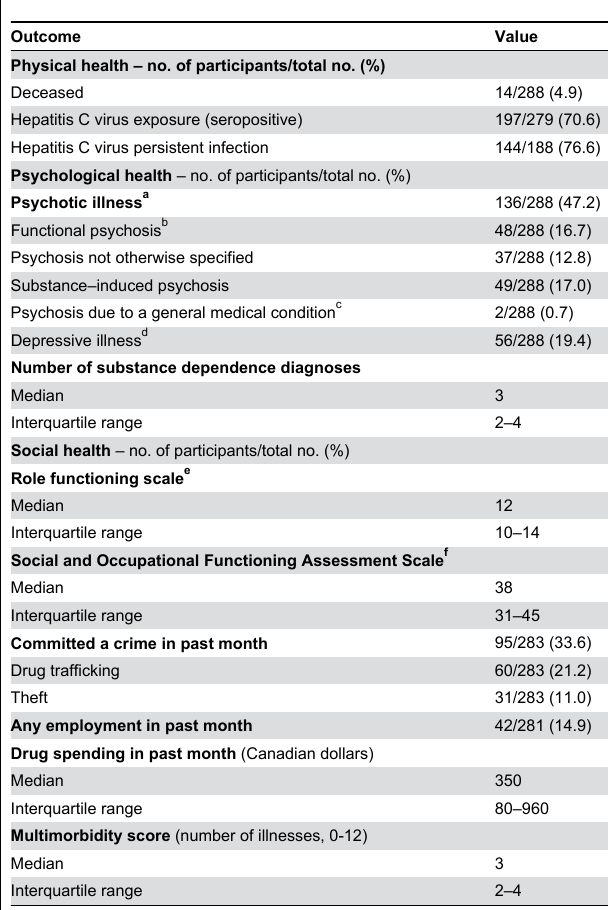
Table 2. Health outcome